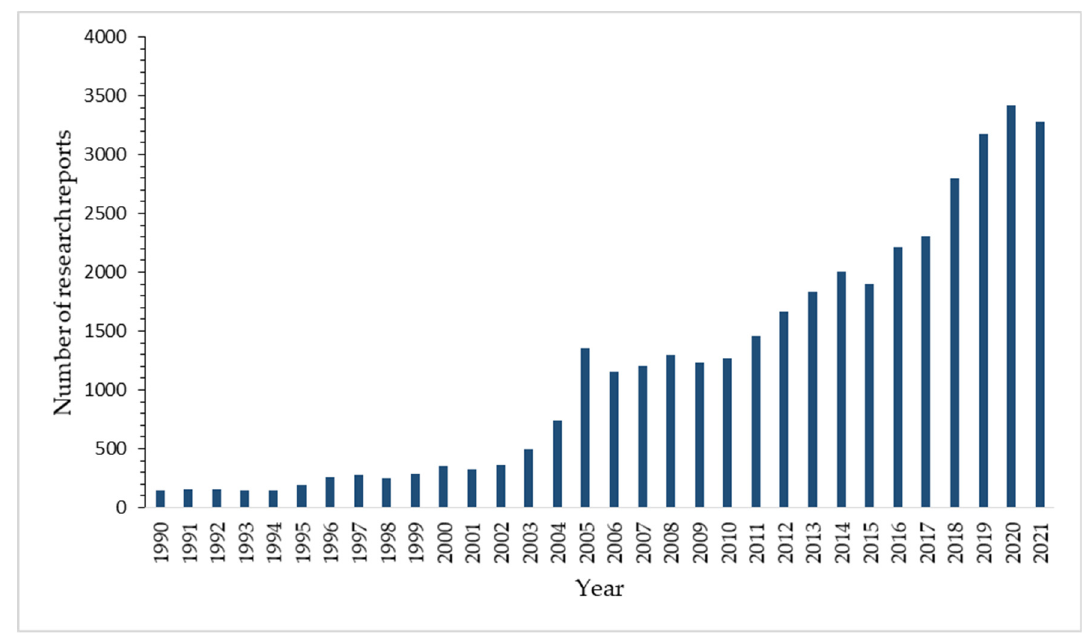
Figure 3. Number of research reports published since 1990 based on the Scopus search.